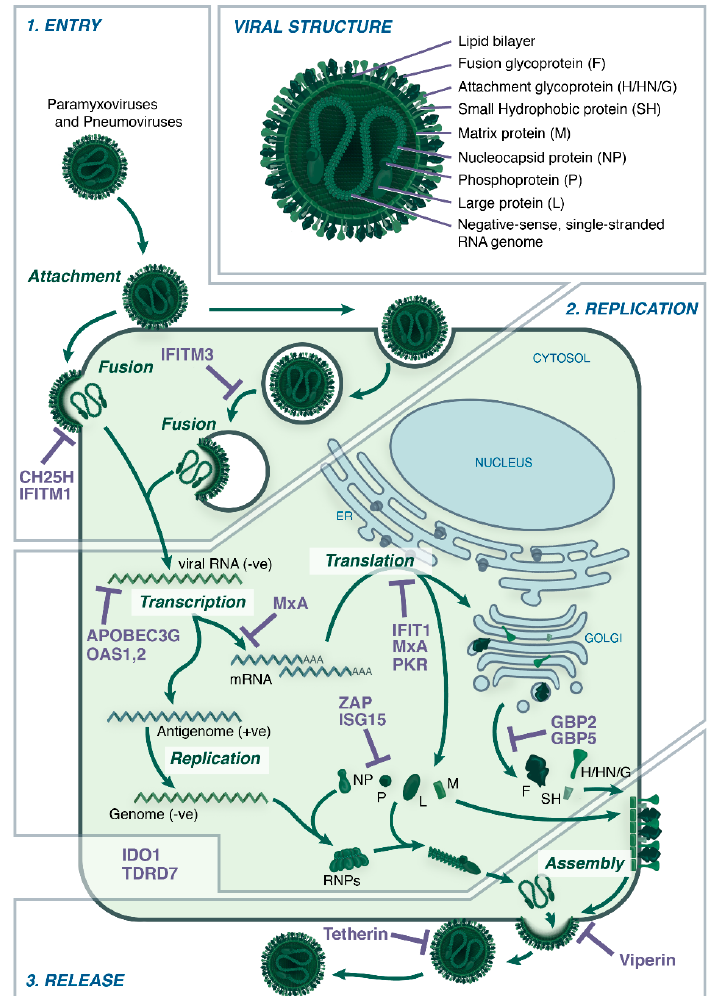
Figure 1. Structure and Replication of Paramyxo- and Pneumoviruses. Paramyxo- and pneumoviruses share a common structure comprising surface fusion (F) and attachment (H/HN/G) proteins (and an additional small hydrophobic (SH) protein for some) located in a host-derived lipid bilayer. Beneath this layer, the matrix (M) protein forms a shell within which is contained the ribonucleocapsid, comprising the phosphoprotein (P) and Large (L) polymerase subunit, as well as a negative-sense, single-stranded RNA genome bound by nucleoprotein (NP) in the form of ribonculeoproteins (RNPs). (1) Upon attachment to the host cell via H/HN/G proteins, paramxyovirus and pneumovirus entry is facilitated by the F protein, releasing the ribonucleocapsid into the cytosol. Pneumoviruses may additionally enter the cell via endocytosis. CH25H, IFITM1 and IFITM3 have been identified to inhibit entry of some viruses. (2) Viral RNA is then transcribed to mRNA and the viral proteins translated, with the glycoproteins (H/HN/G, F and SH) travelling through the ER to the Golgi before reaching the cell surface. Viral RNA is additionally transcribed to produce a positive-sense antigenome, which is replicated to give negative-sense genomic RNA. Restriction factors known to inhibit these stages of virus replication include, ABOBEC3G, OAS1, OAS2, MxA, IFIT1, PKR, ZAP, ISG15, GBP2, and GBP5. The exact step in the virus replication process inhibited by IDO1 and TDRD7 has not been identified. (3) After genomic replication, RNA associates with the NP to form RNPs, as well as the P and L proteins, and traffics to the cell membrane where it interacts with M protein. Once this ribonucleocapsid is assembled with the surface proteins, newly-formed virions are released by budding. The restriction factors tetherin and viperin can interfere with assembly and budding.